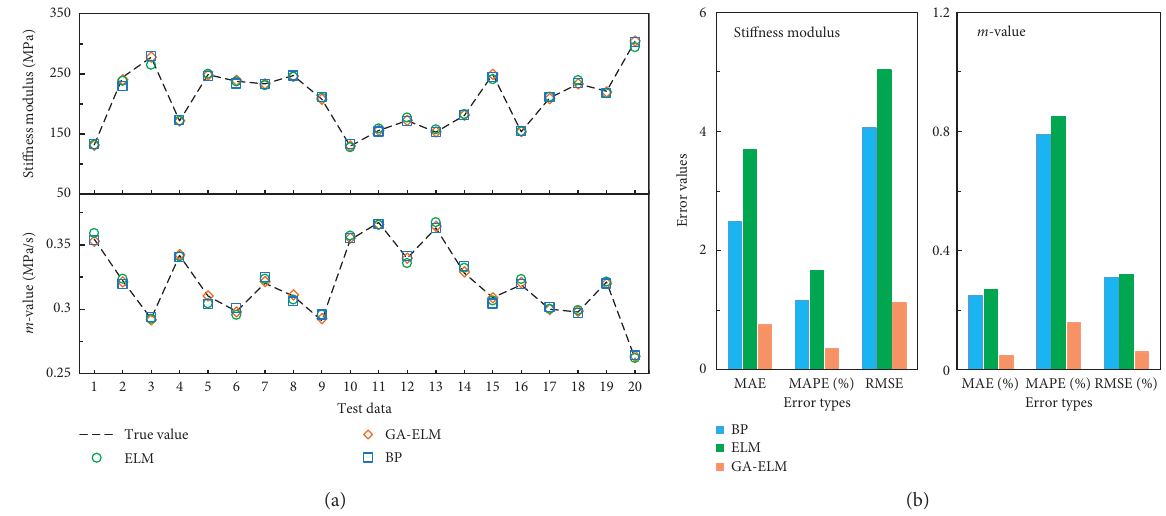
Figure 5: Prediction accuracy comparison of different models. (a) Predictive value comparison. (b) Error